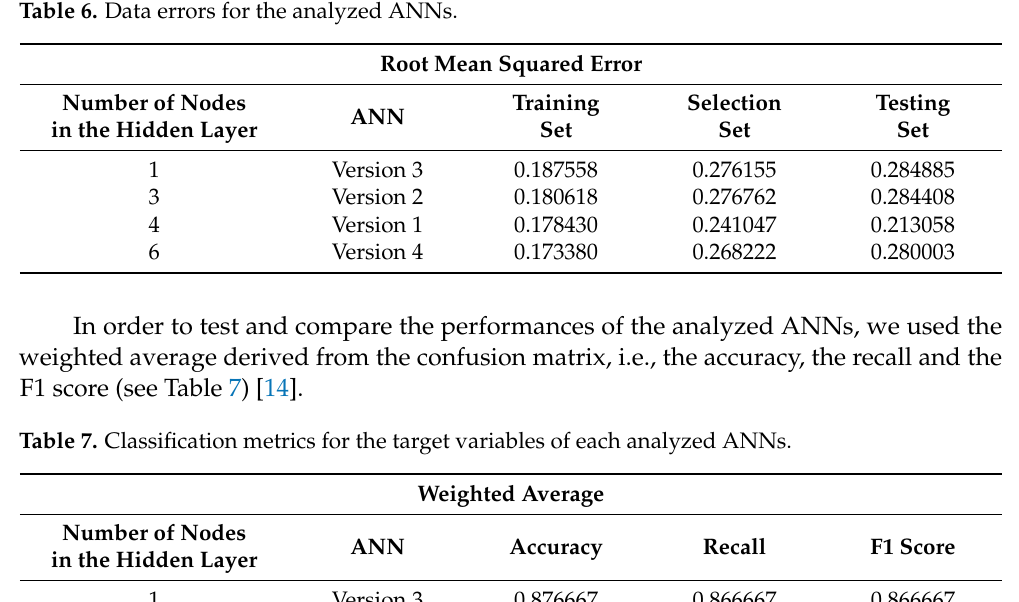
Table 6. Data errors for the analyzed ANNs.